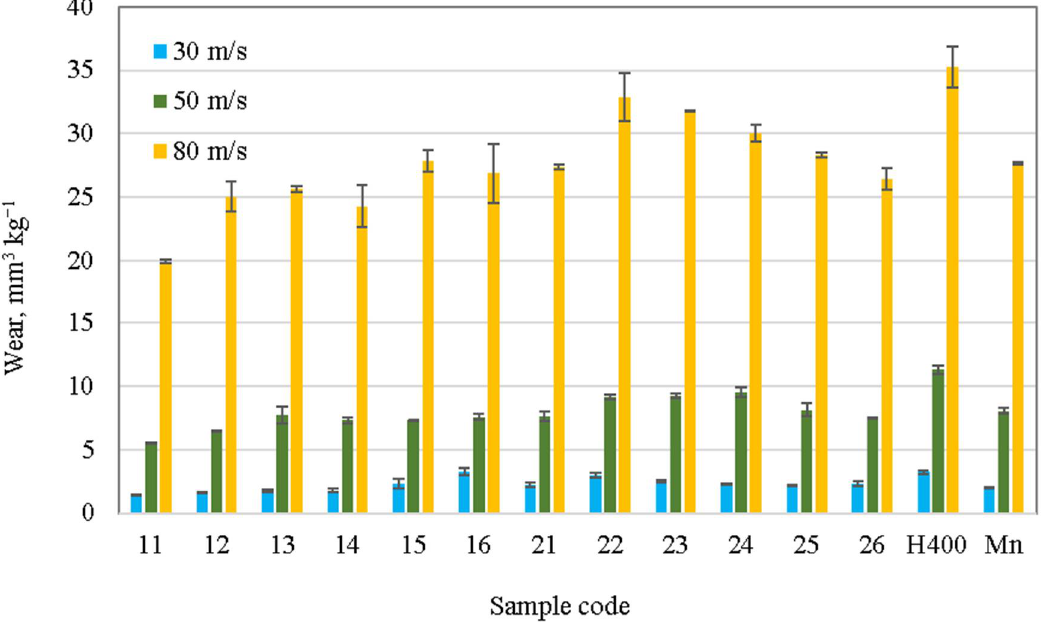
Figure 6. Effect of erodent impact velocity on wear rate of materials tested under impact angle of 30°.